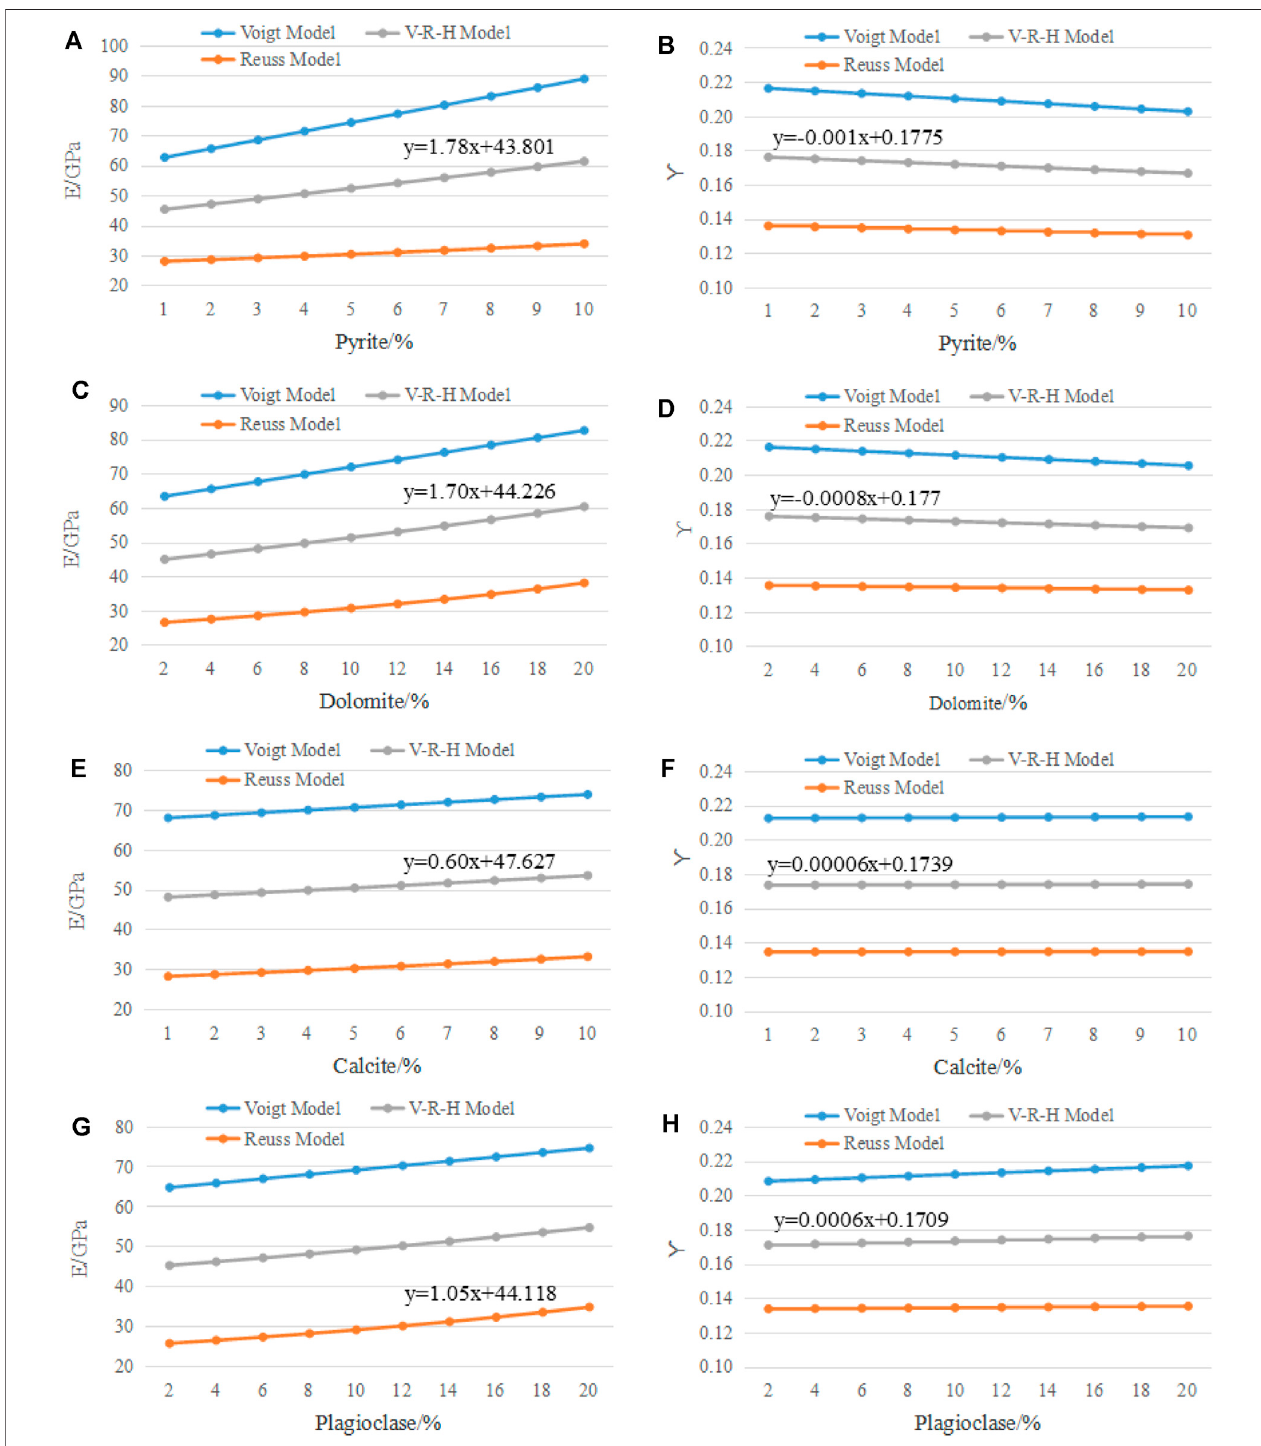
FIGURE 13 | Elastic parameters versus pyrite (A,B) , dolomite (C,D) , calcite (E,F) and plagioclase (G,H) content, respectively.